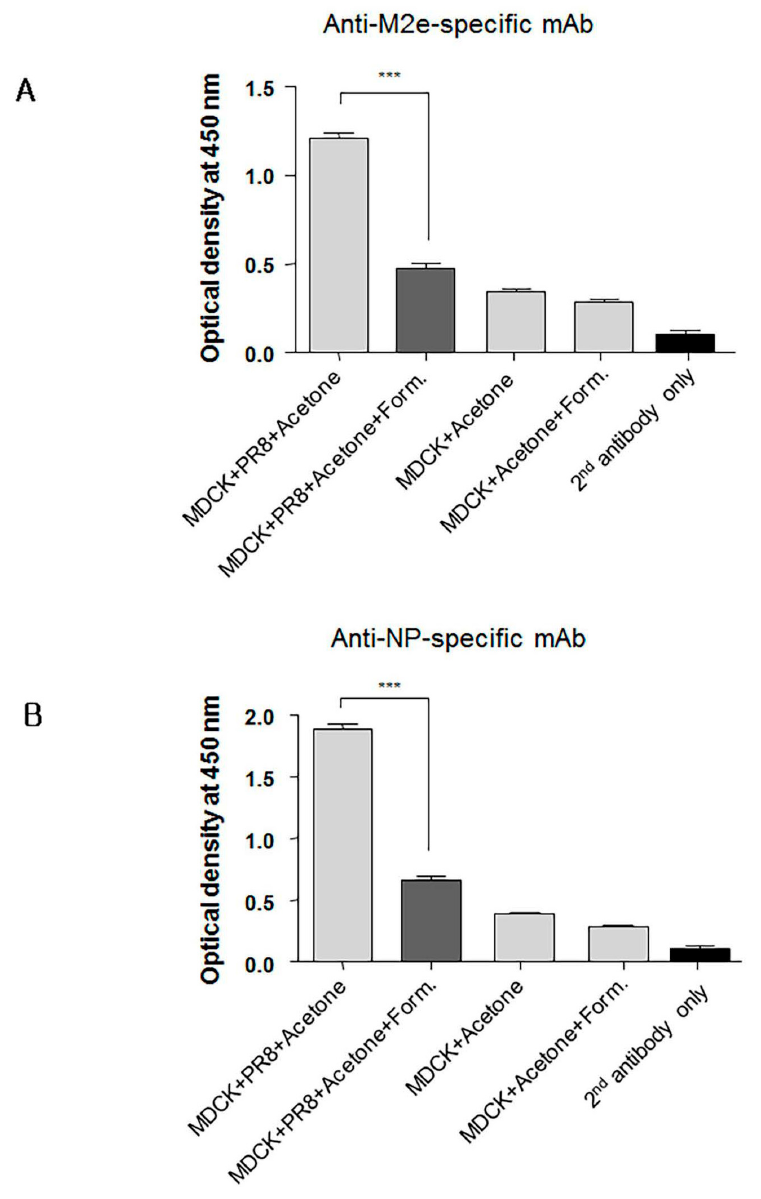
Figure 8. Formaldehyde treatment alters in the antigenicity of the M2 and NP viral proteins. Confluent MDCK cells cultured in 96-well flat bottom plates were infected with influenza A virus (IAV) to provide expression of nucleoprotein (NP) and M2. The plates were then treated with acetone and subsequently with formaldehyde or PBS for use in cell-based ELISA for detection of M2e-( A ); or NP-specific monoclonal antibodies (mAbs) ( B ). Non-infected MDCK cells were included to determine level of background. Secondary (2nd) HRP-conjugated antibody alone was used as a negative control. The data represent results from three independent ELISA with six wells per antigen in 96-well plates (*** p < 0.0001).